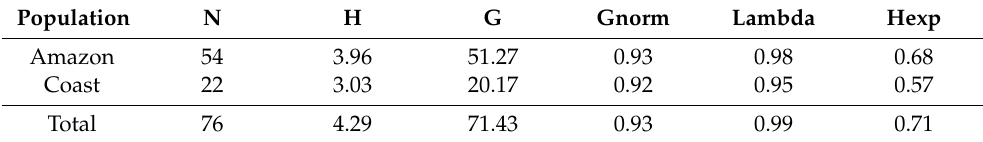
Table 1. Genetic diversity statistics of the coastal and Amazon populations of M. roreri .